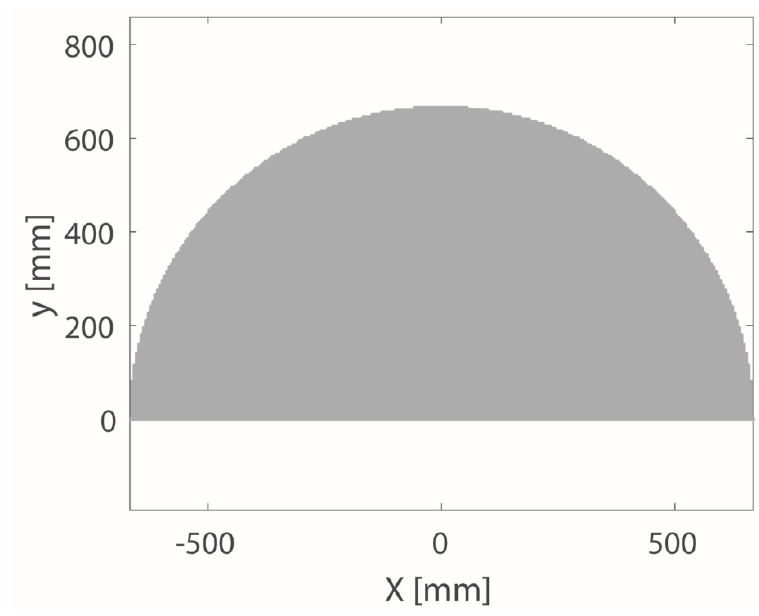
Figure 1. Workspace of the upper limb on a horizontal plane.